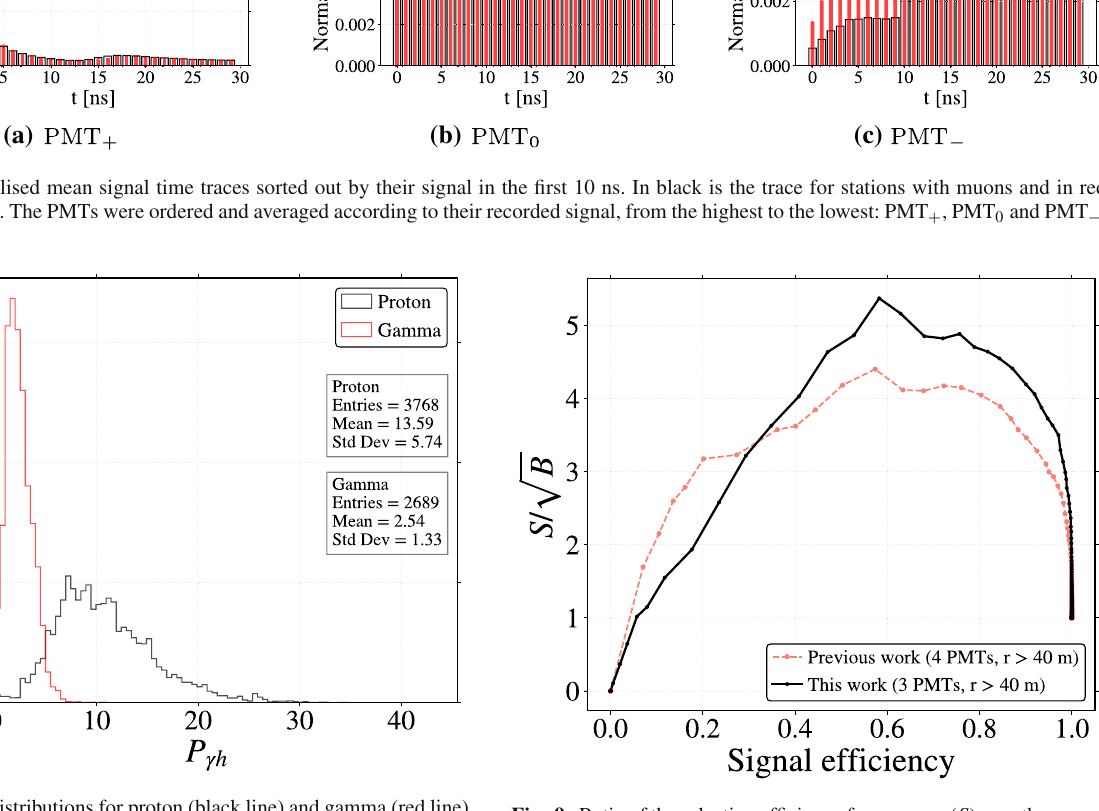
root of the selection efficiency for protons ( B ) as a function of S . The dashedlinecorrespondstotheresultobtainedwith4PMTsinaprevious work